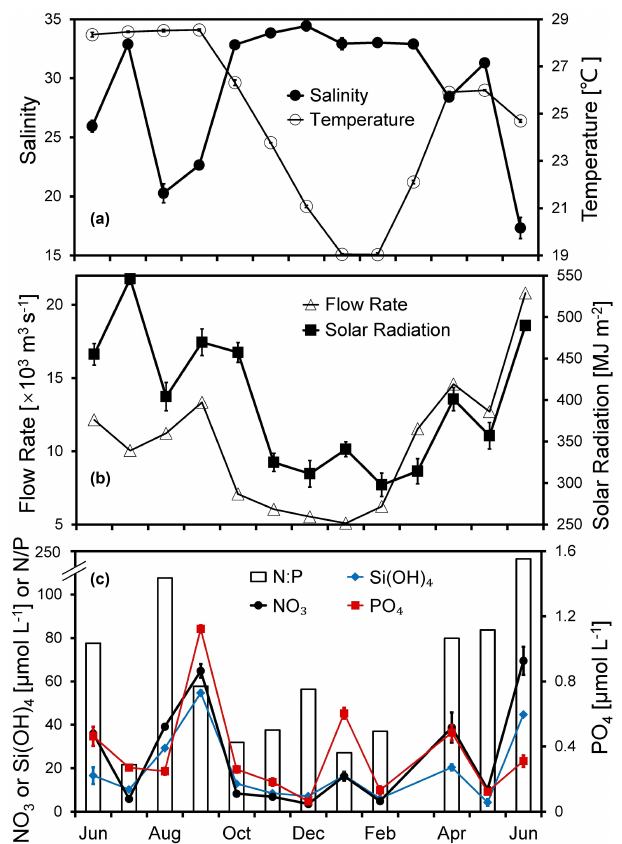
Figure 2. Temporal variations in (a) temperature, salinity, (b) flow rate, solar radiation, (c) nitrate, silicate, phosphate, and N/P ratio of the surface water at the Wanshan station from June 2018 to June 2019. Error bars are standard deviations.